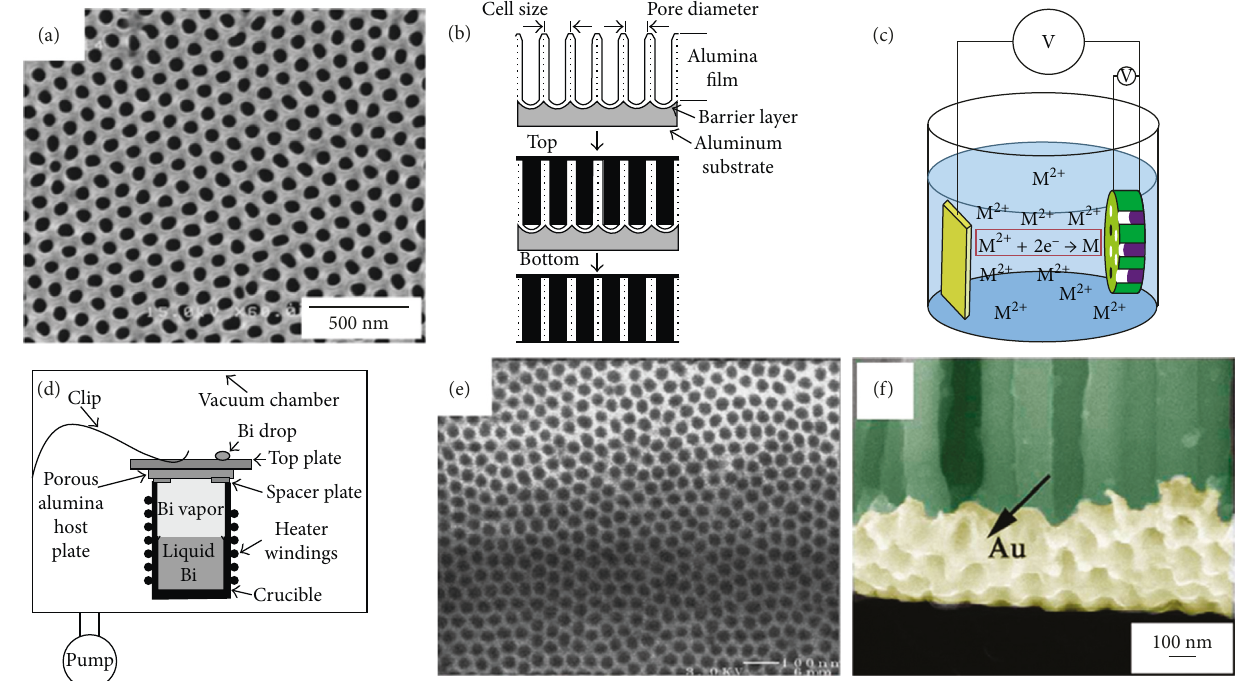
Figure 3: (a) Scanning electron microscope (SEM) image of an anodized aluminium oxide (AAO) template. (b) Growth mechanism in the liquid-phase method with an AAO template.(c) Schematicillustration oftheelectrochemical depositionin theAAO poresto fabricate nanowires. (d) Schematic diagram of the vacuum chamber, including a crucible for growing the nanowires by vapor-phase deposition. (e) SEM image of Bi nanowires in an AAO template. (f) SEM image of Bi nanotubes prepared by electrochemical deposition in an AAO template. Reprinted with permission from [75] Cambridge University Press, [76] American Institute of Physics, and [77] American Physical Society.